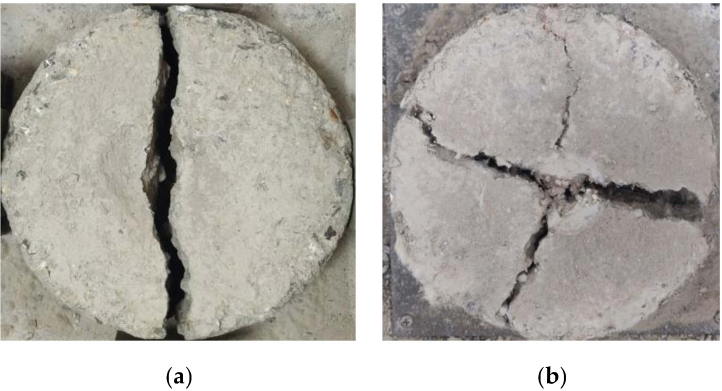
Figure 4. ( a ) Impact rupture form in ordinary concrete; ( b ) impact rupture form in SPRC. Table 3. N 1 and N 2 under concrete drop-hammer impact.